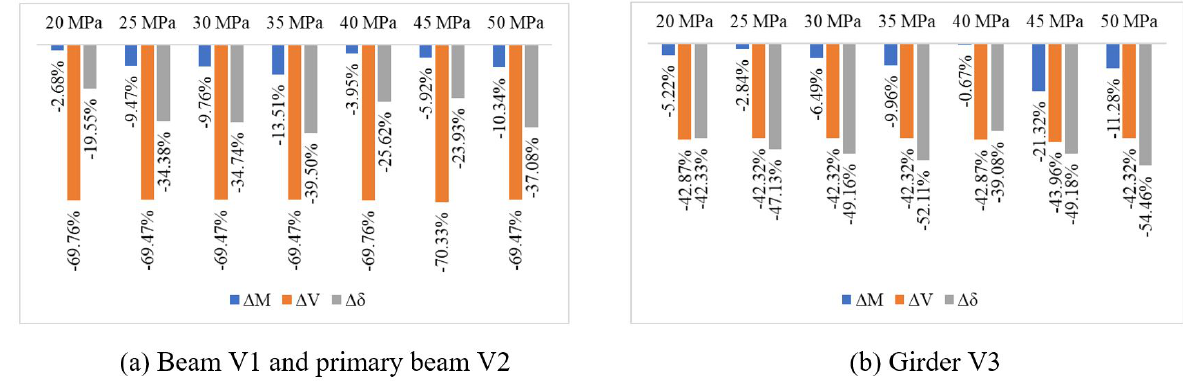
Figure 6. Verification of SLS and ULS